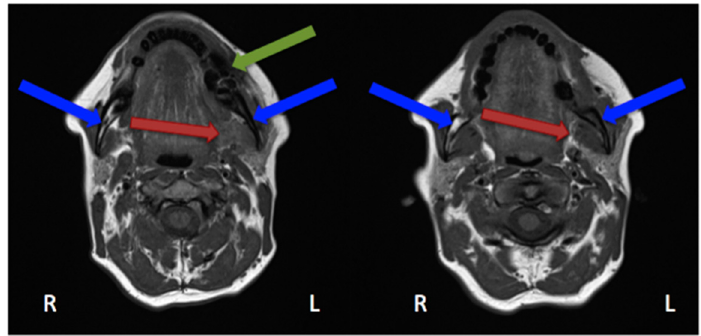
Figure 6. Magnetic resonance imaging (Siemens, Avanto, 1.5T, Sequence: T1 tse tra) Patient: 48 years old, female, metastatic breast cancer, zoledronic acid for 2 years (panoramic radiograph Figure 1). Green arrow showing the MRONJ necrosis, red arrows showing the oedema, blue arrows showing the differences between the right side: normal fatty bone marrow and left side: signal loss, due to loss of fat. Pair of screenshots. AAMOS staging: stage 2.